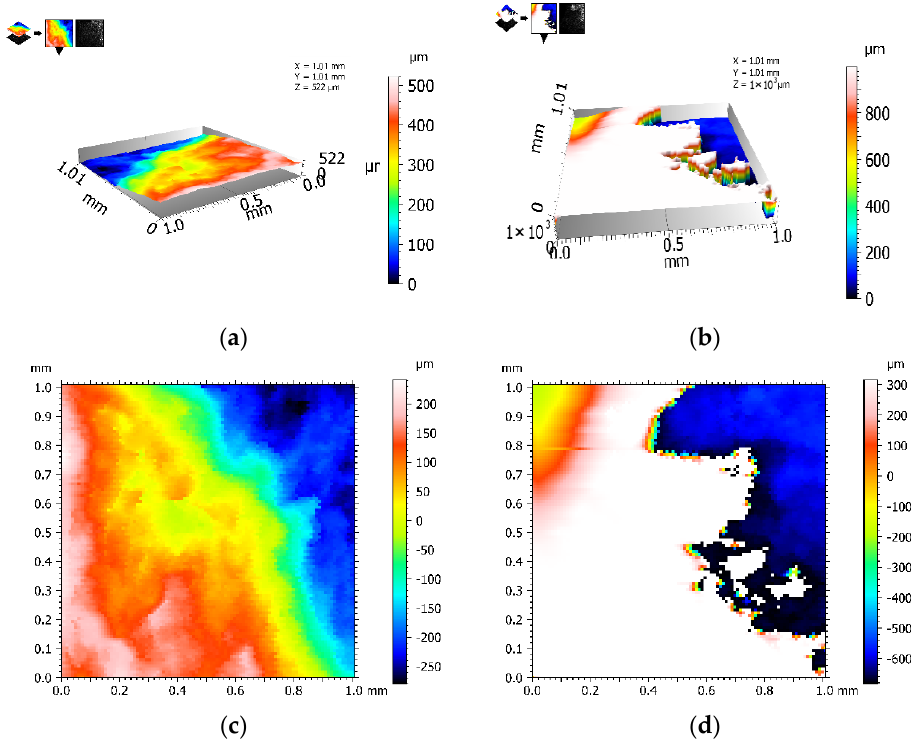
Figure 5. Scanning results for Q235 galvanized steel: ( a ) 3D morphology of the air; ( b ) 3D morphology of 5wt% NaCl; ( c ) surface morphology in air; ( d ) surface morphology in 5wt% NaCl.